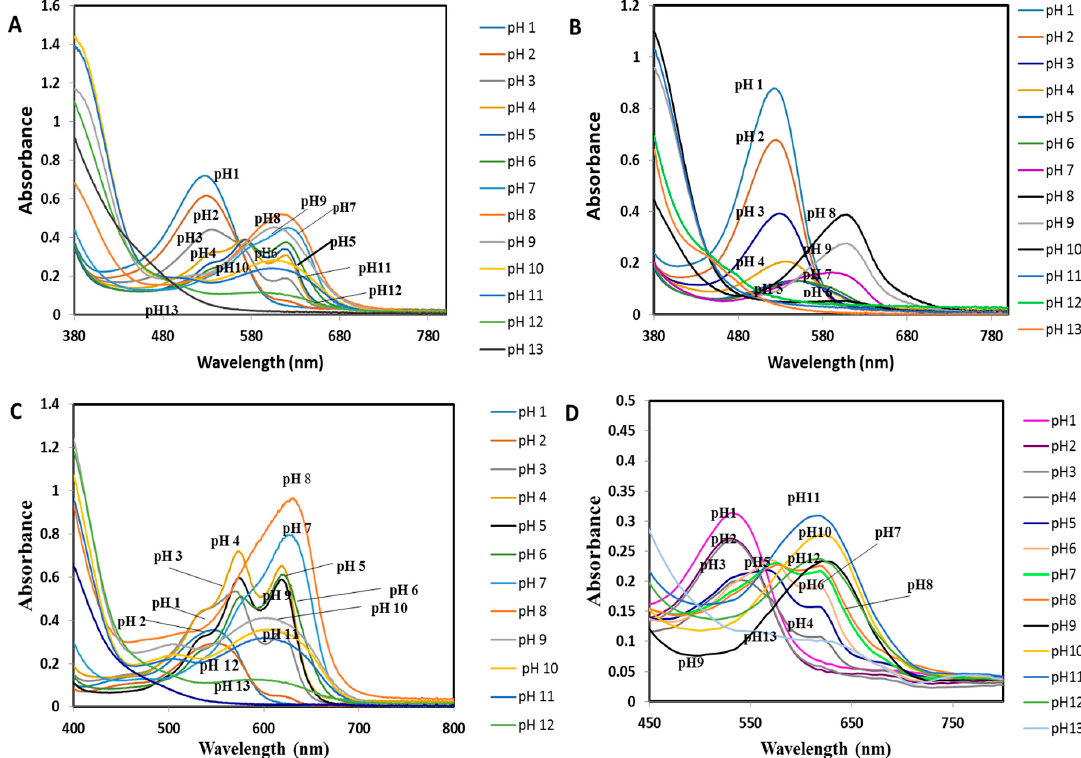
Figure 2. UV-vis spectra of the non-immobilized dye extracts of ( A ) mixed natural dyes ( Brassica sp